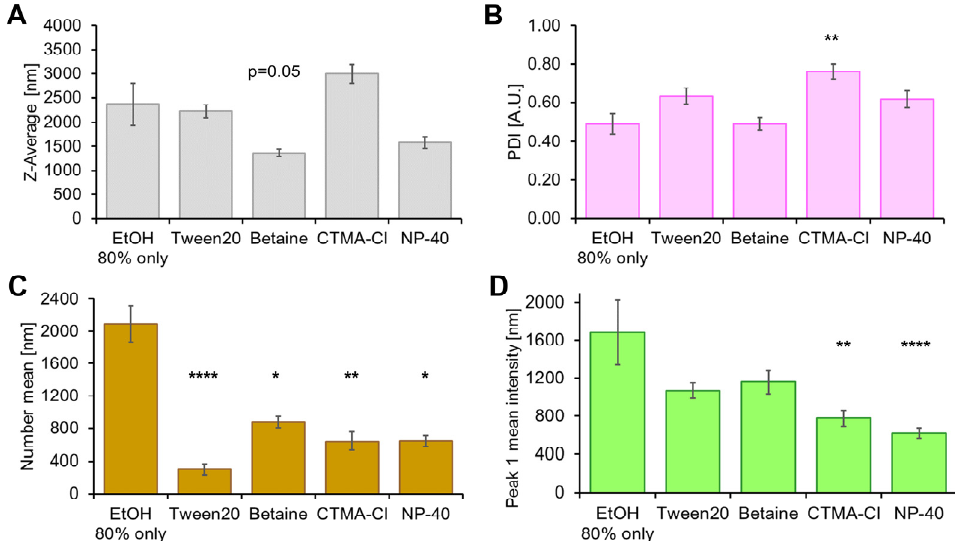
Figure 5. DLS parameters ( A ) z-average, ( B ) PDI, ( C ) number mean, ( D ) peak 1 mean intensity of the HES-NCs 1144d and g after transfer into EtOH (80%). Different stabilization approaches by adding 0.1% ( w / v ) of the surfactants Tween 20, betaine monohydrate, CTMA-Cl or NP-40 are shown in comparison to EtOH 80% only. Significances in comparison to EtOH only are indicated by asterisks with * = p < 0.05, ** = p < 0.01, **** = p < 0.0001 as determined by Bonferroni-adjusted post hoc tests after Kruskal–Wallis ANOVA. Mean values ± SEMs of n = 5 to 18 samples with n = 3 to 4 measurements and 12 sub-runs each are